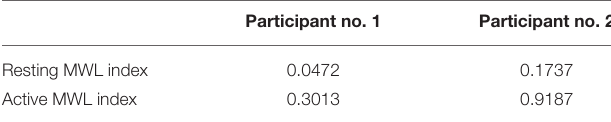
TABLE 1 | Average MWL indexes for both subjects in the cases of resting and active